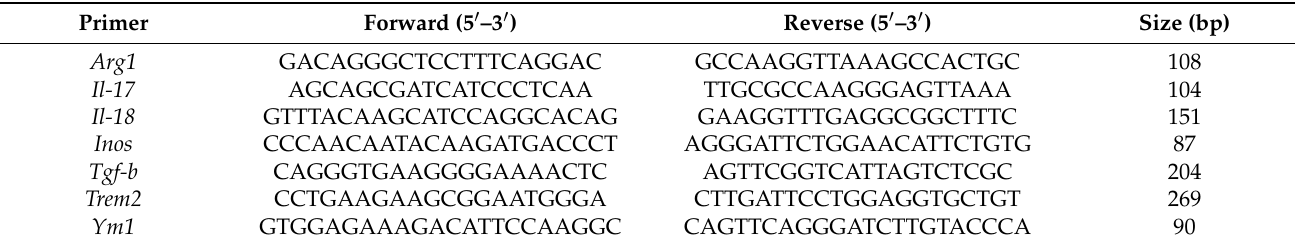
Table 2. Primers used for real-time